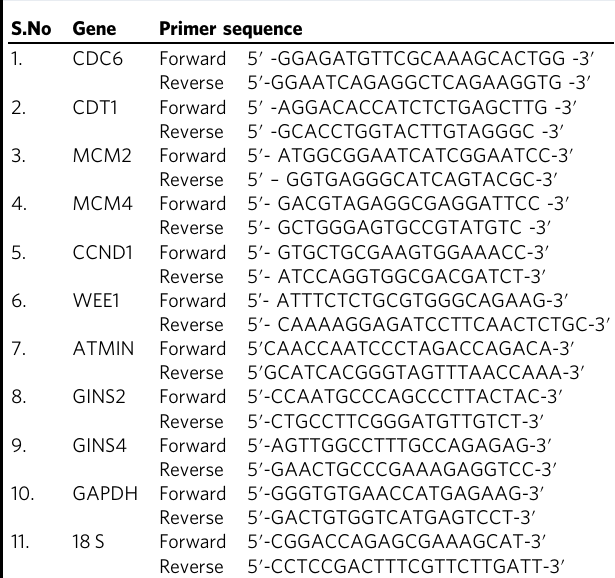
Table 2 List of primers used in the